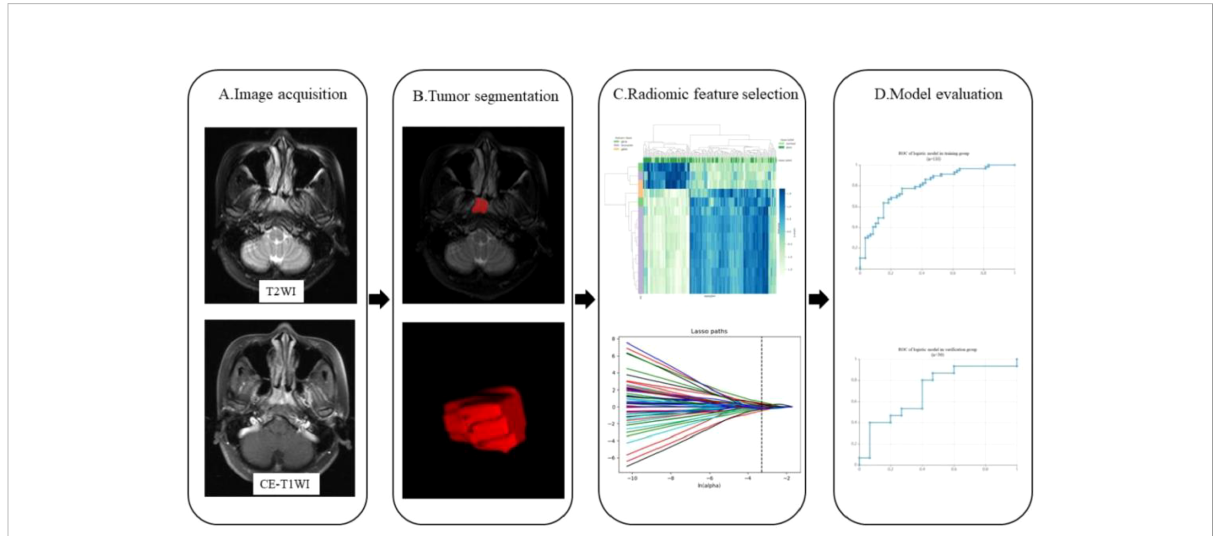
FIGURE 1 Work fl ow showing the establishment of a radiomics model based on MRI for predicting DM of NPC. The steps include (A) MR image acquisition, (B) tumor segmentation, (C) radiomics features selection, and (D) model